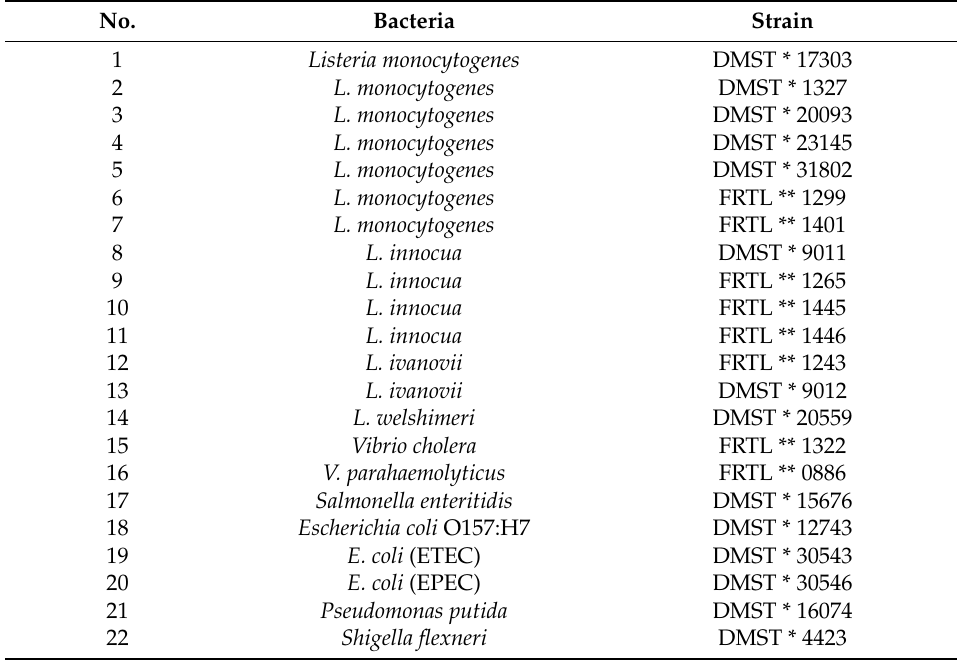
Table 2. Bacterial strains used in this study and their